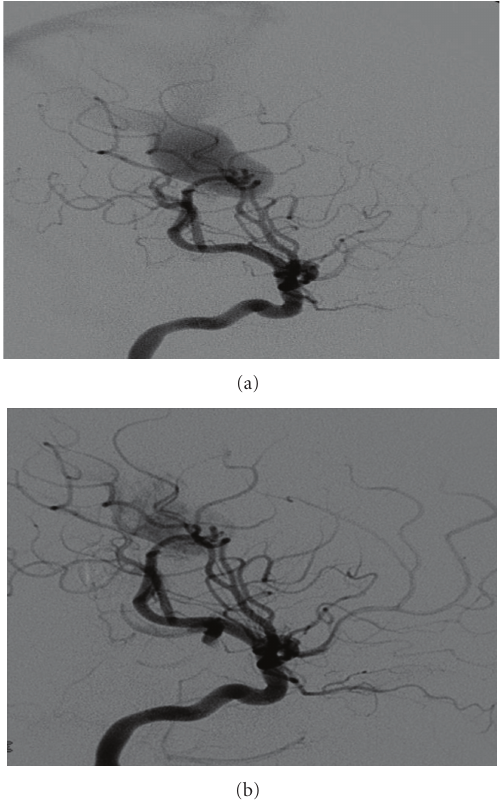
Figure 4: Digital subtraction angiography: internal carotid artery lateral and early filling of the Vein of Galen before (a) and after (b).